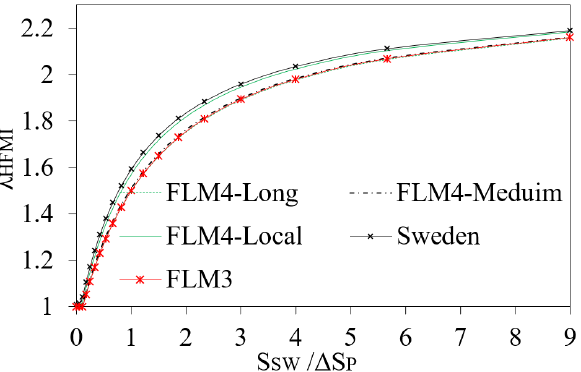
Figure 16. Comparison between Φ – λ HFMI curves for fatigue load models and original Swedish real traffic (midspan of a simply supported bridge with a span length, L = 10 m).